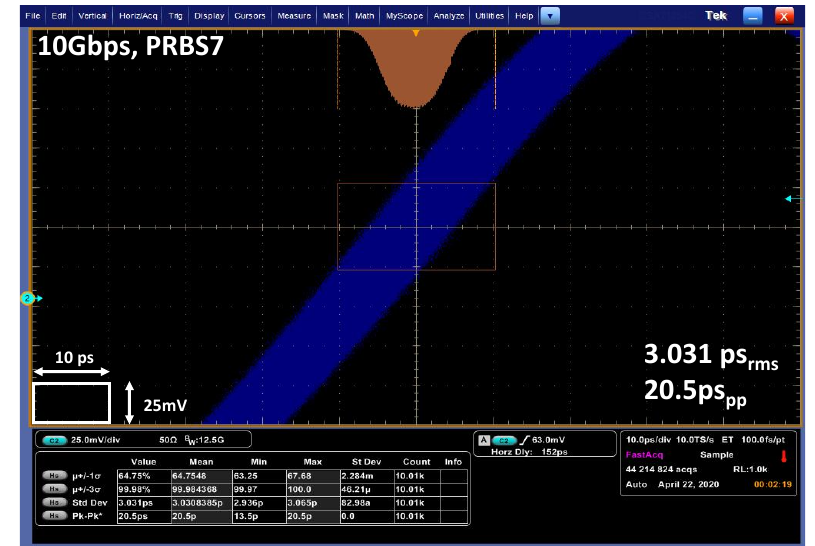
Figure 16. Recovered clock at 10